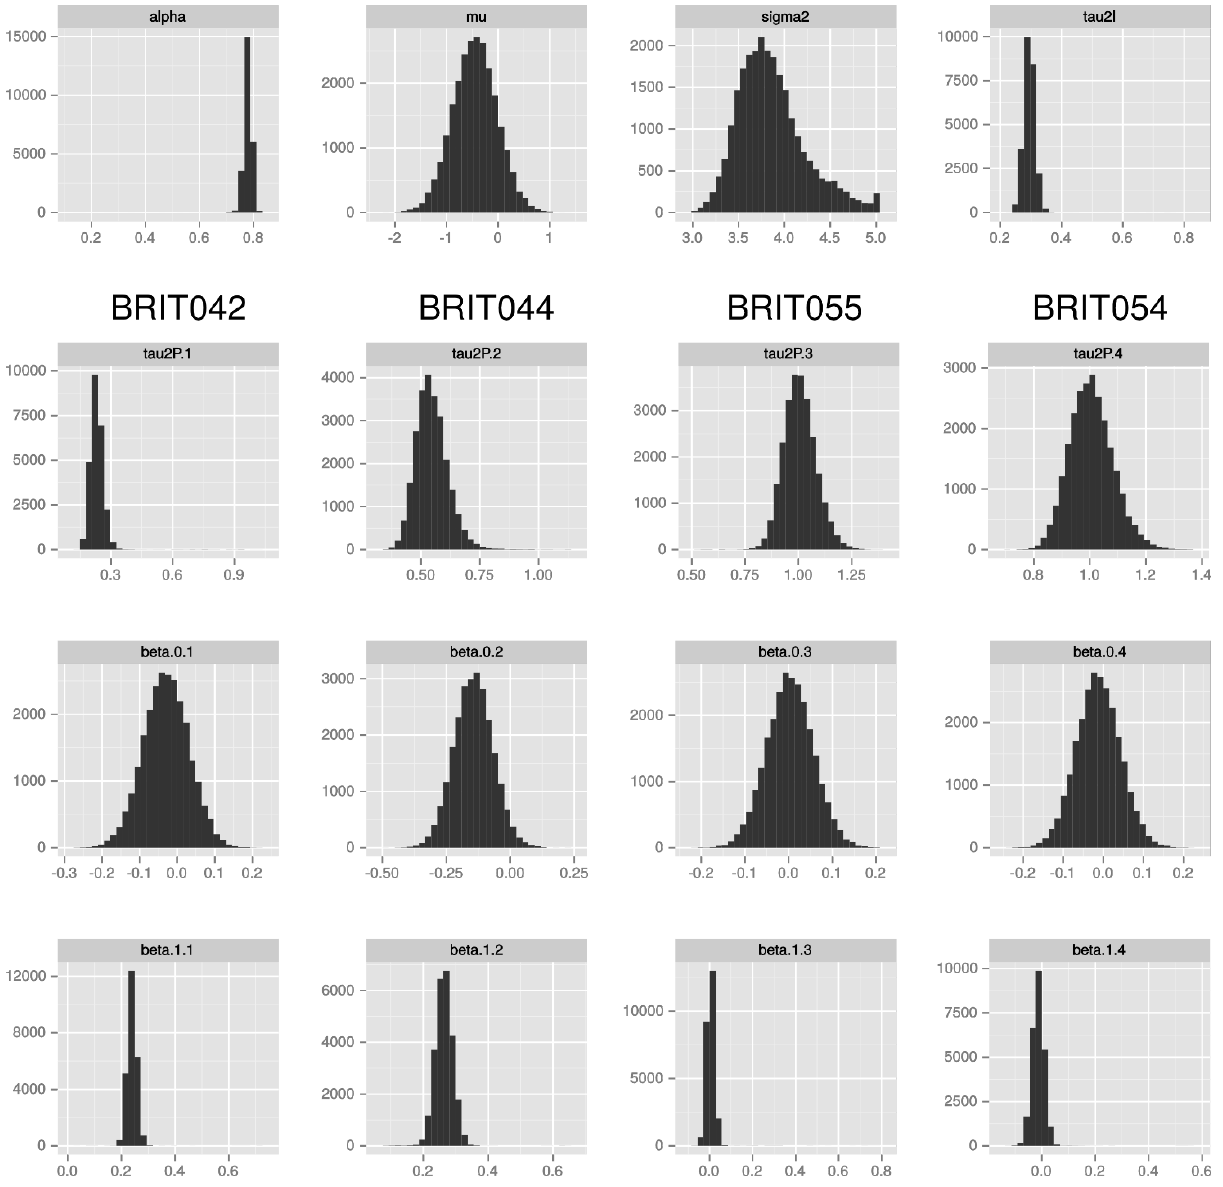
Figure A1. Histogram of drawn parameters, process level and instrumental noise ( top row ) and data level (proxy response) arranged by columns. Proxy noise strength in second row, offset b 0 and slope b 1 in third and fourth